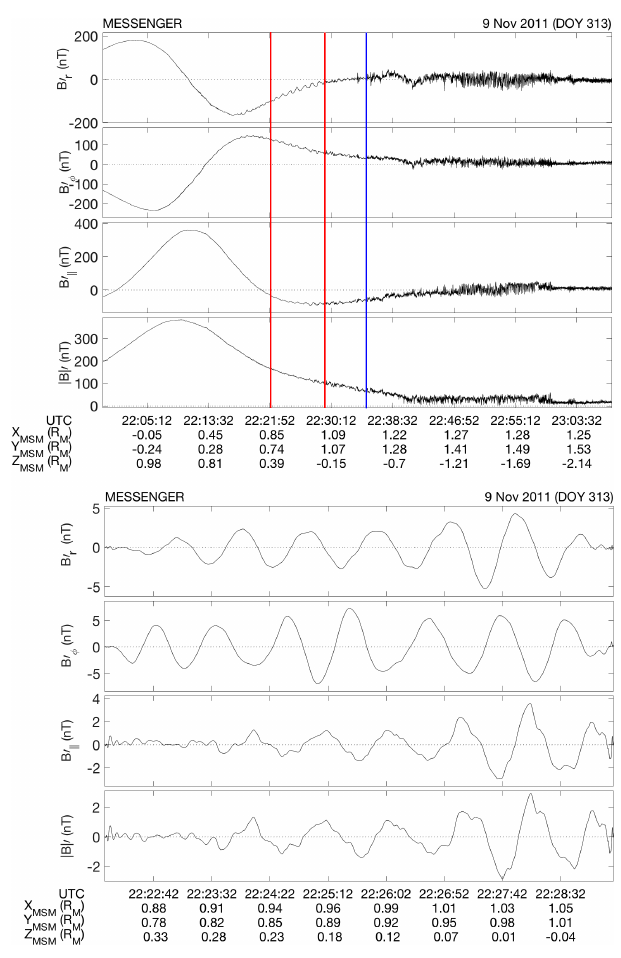
Figure 1. The upper panel shows an example of a magnetospheric traversal, in which red lines mark the ULF wave signature and the blue line marks the magnetopause. The lower panel shows the de- trended and smoothed ULF wave